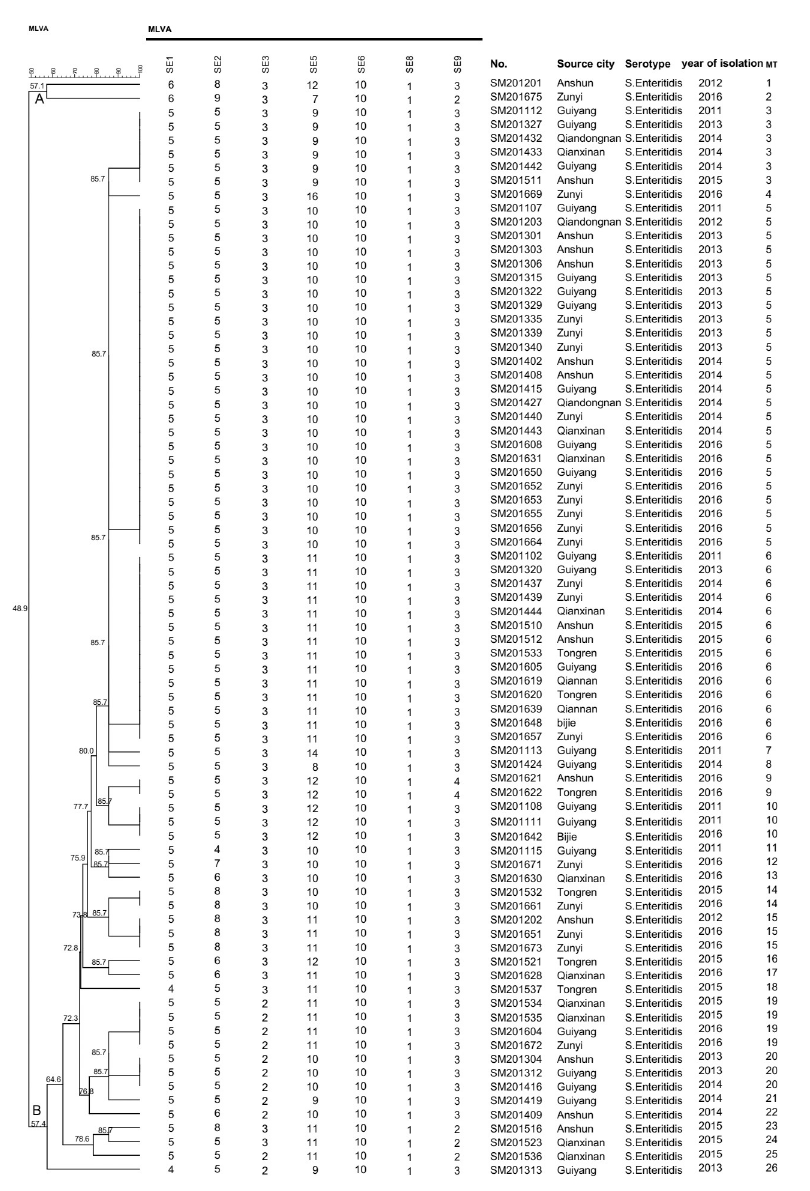
Fig 3. Multiple-locus variable-number tandem repeat analysis (MLVA) types of S . Enteritidis isolates from Guizhou province. The dendrogram was generated by UPGMA. The corresponding MLVA type (MT) with copy numbers of the seven loci and background information were shown on the right of the